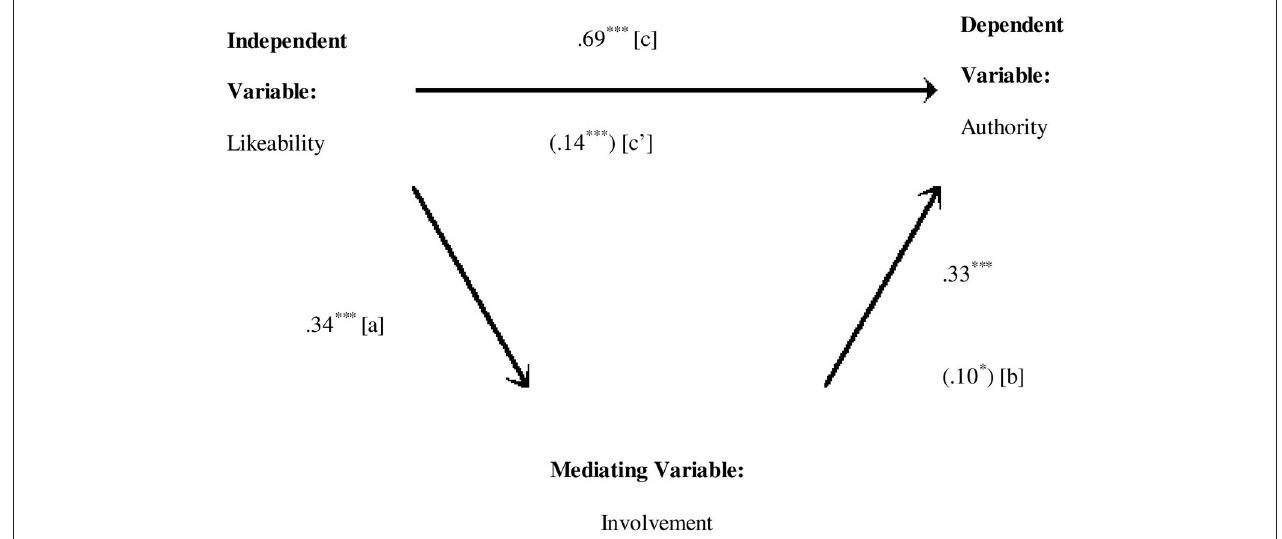
FIGURE 2 | Medgraph shows indirect effect of likeability and authority through involvement (perceived). The numerical values in parentheses are beta weights taken from the second regression and the other values are zero order correlations. *** p < 0.001 and * p < 0.05.